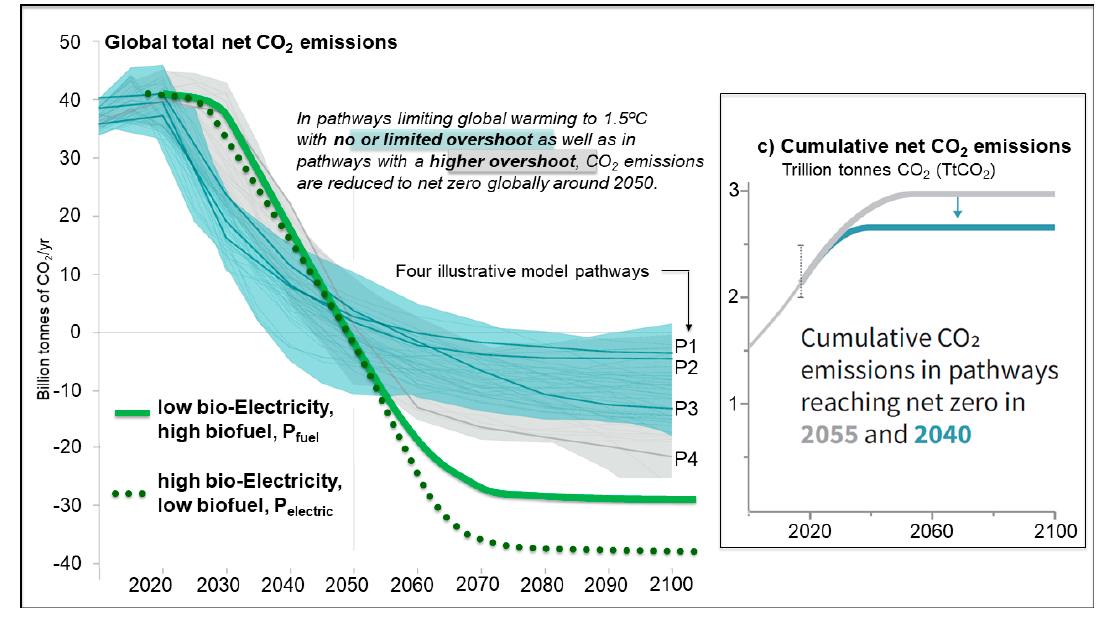
Figure 2. The two paths, P fuel and P electric , superimposed on the four pathways of the IPCC 1.5 °C target [4] reflect annual emissions projections from IPCC Figure SPM.3a (left) plus IPCC cumulative projections from SPM.1c on the right. (Note: The P fuel and P electric paths are smoothed lines between three calculated points. The IPCC Figure SPM.3a pathways are smoothed lines with many calculated points.).